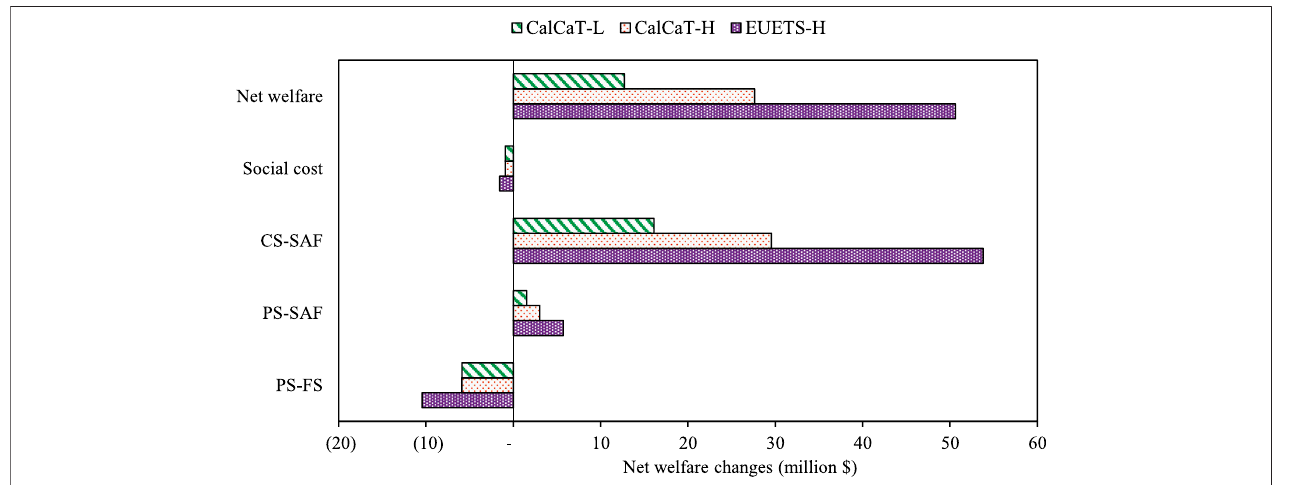
FIGURE 4 | Changes in net welfare for carbon credit scenarios against the Baseline. Note: PS-FS, PS-SAF and CS-SAF denote surplus for feedstock producers, surplusforSAFprocessorandsurplusforSAFconsumers,respectively.CalCaT-L,CalCaT-HandEUETS-HdenotelowestcarbonpriceintheCaliforniaCap-and-Trade program, highest carbon price in the California Cap-and-Trade program and highest carbon price in the European Union Emission Trading System,